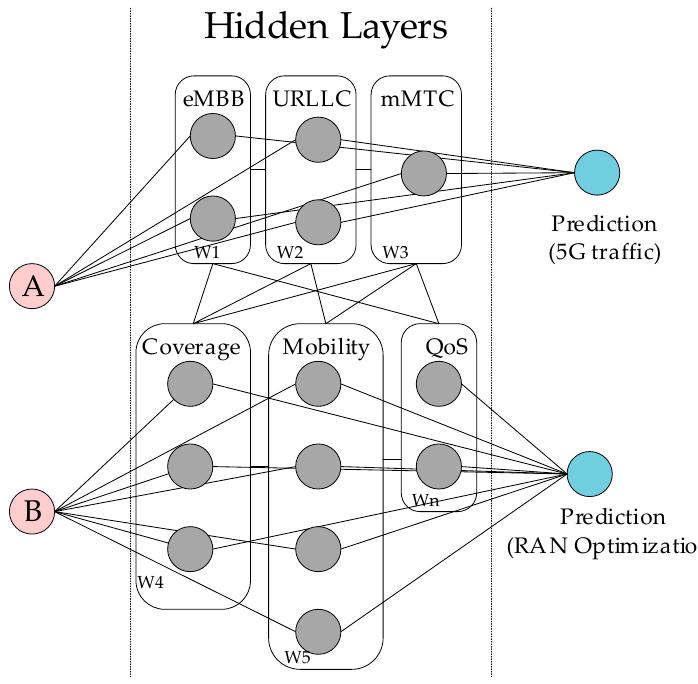
Figure 8. The model for training data collection in different 5G usage scenarios.